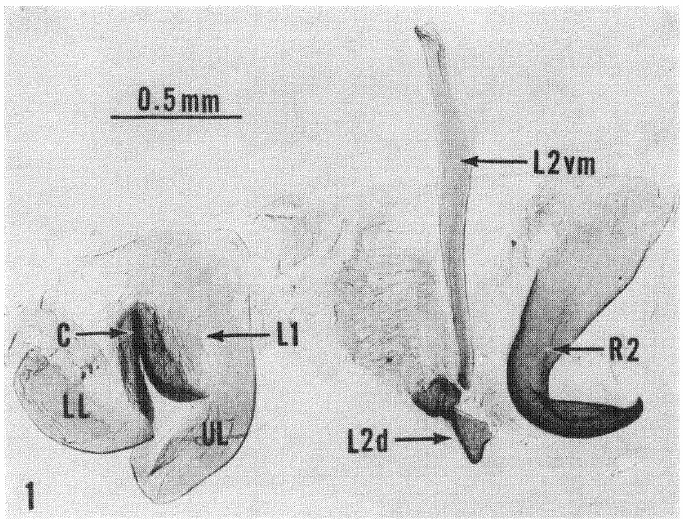
Figure 1. (62 BMNH). Male genitalia (dorsal) of Cyrtotria latitennis (Kirby), British East Africa (from / shown in Fig. 37). Left (L) and right (R) phallomeres numbered aeeording to MeKittriek (1964) C cleft of L1; UL and LL--upper and lower lobes of L1,